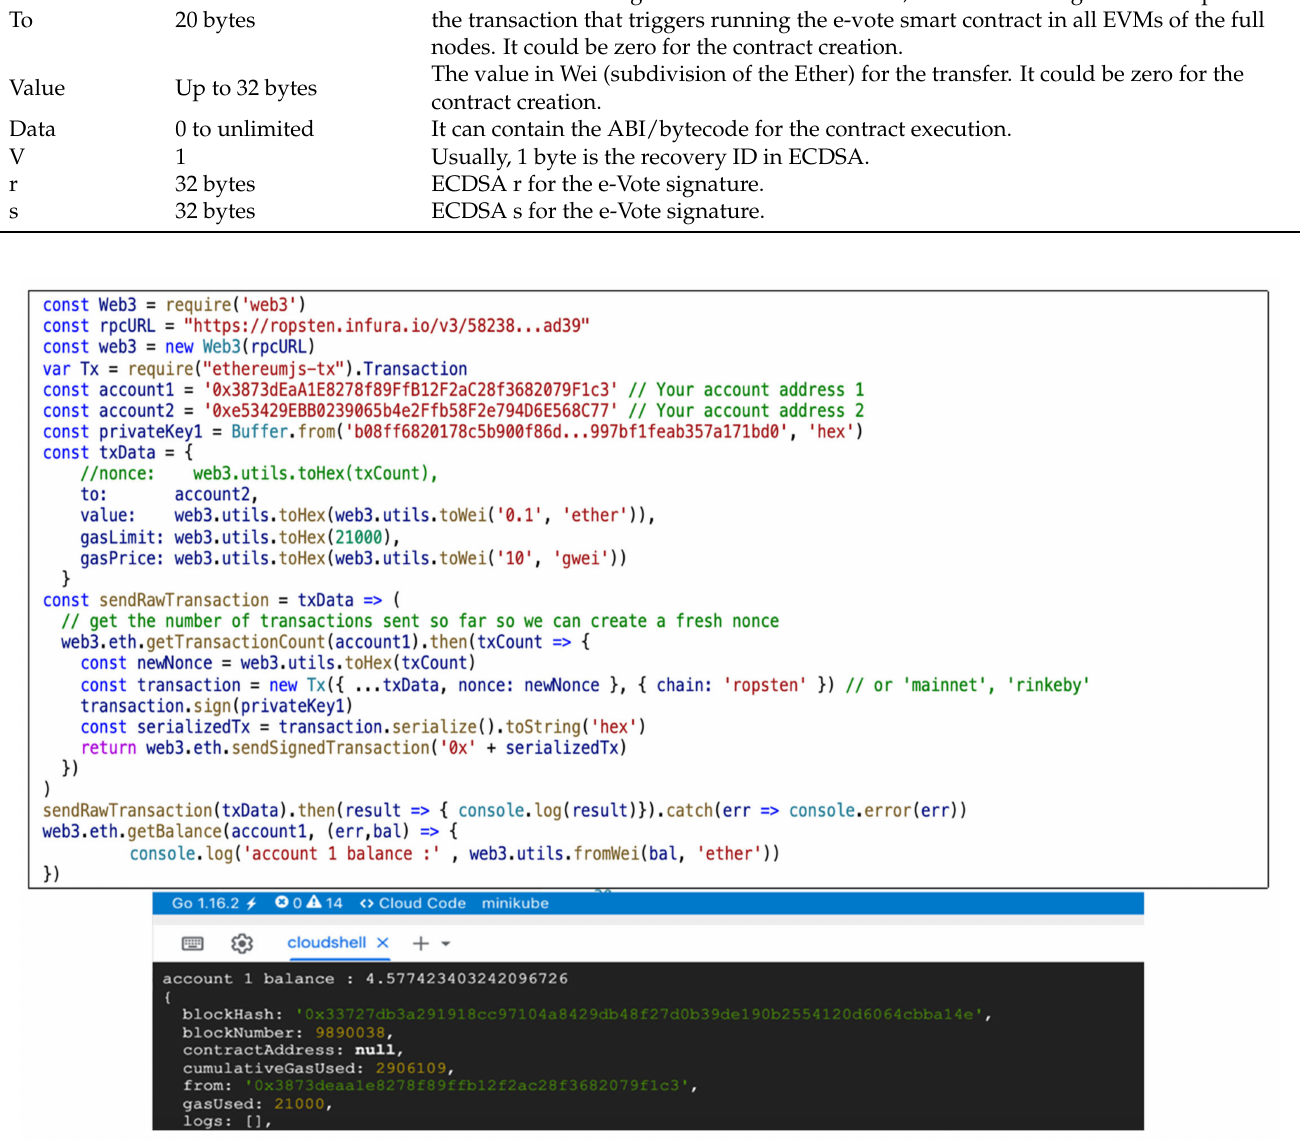
Figure 9. Ethereum web3js/ethers.io API in node.js accessing the Ethereum Gateway for a simple transaction Type